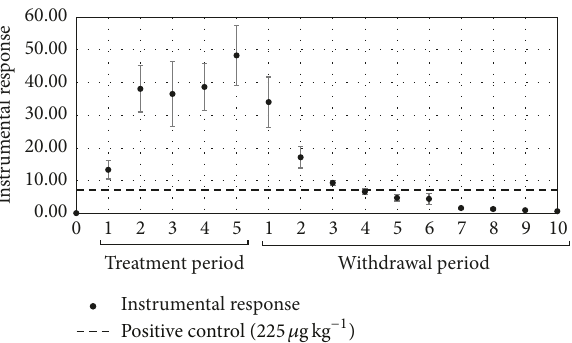
Figure 5: Residues of doxycycline in egg samples from layer hens subjected to a pharmacological treatment with doxycycline during the drug administration period and days of residual